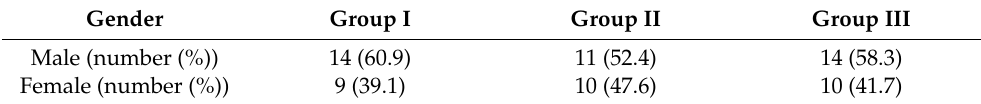
Table 1. Comparison of the general characteristics of the participants in the three groups. Gender Group I Group II